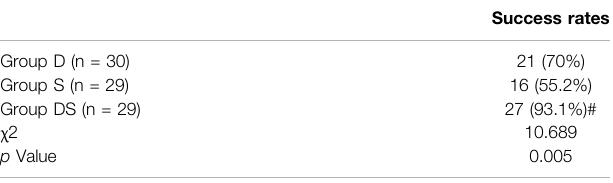
TABLE 1 | Comparison of the intranasal sedation success rate between the groups.